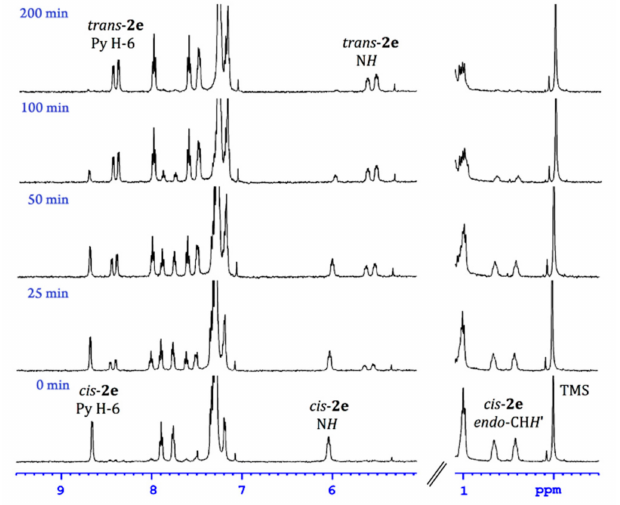
Figure 3. Time-resolved 1 H-NMR spectra for geometrical isomerization of C - 2e to T - 2e , at 253 K in CDCl 3